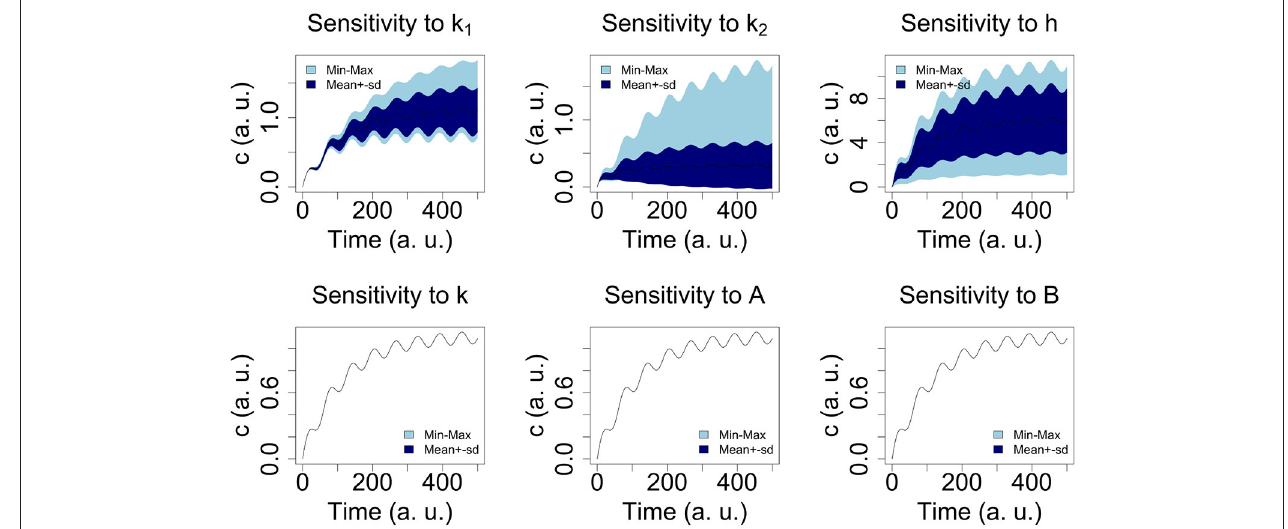
FIGURE 2 | Sensitivity range of the concentration curve to the parameters listed in Table 3 (see text for R-code).